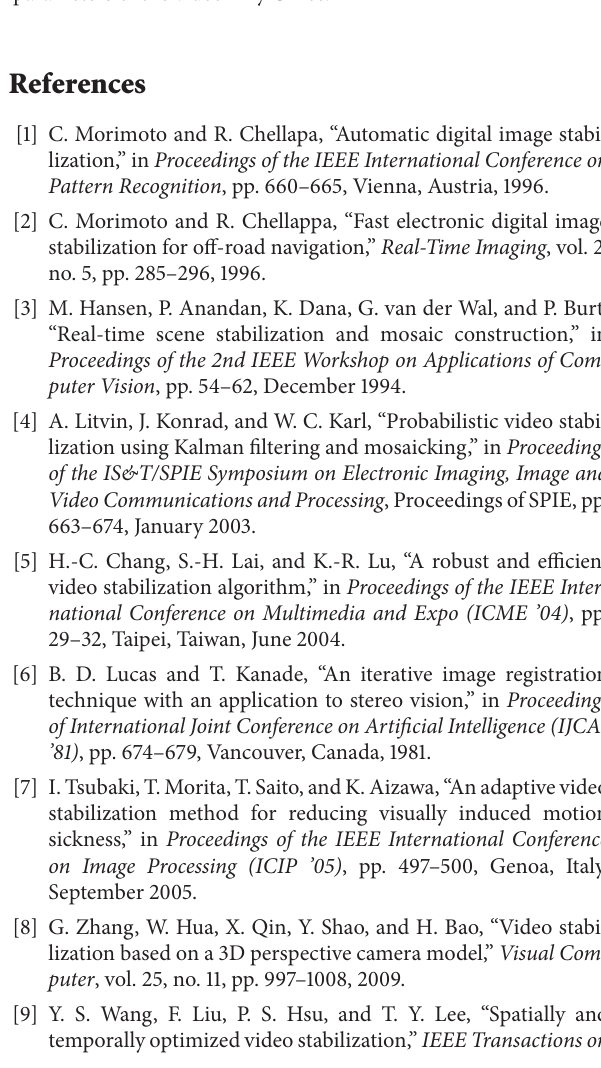
Figure 5: Original and smoothed motion parameters of the video “My Office.”